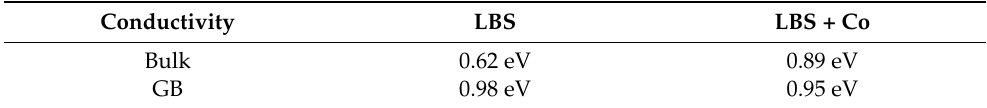
Table 3. Effective activation energies of the bulk and GB conductivity of La 0.95 Ba 0.05 ScO 3- δ